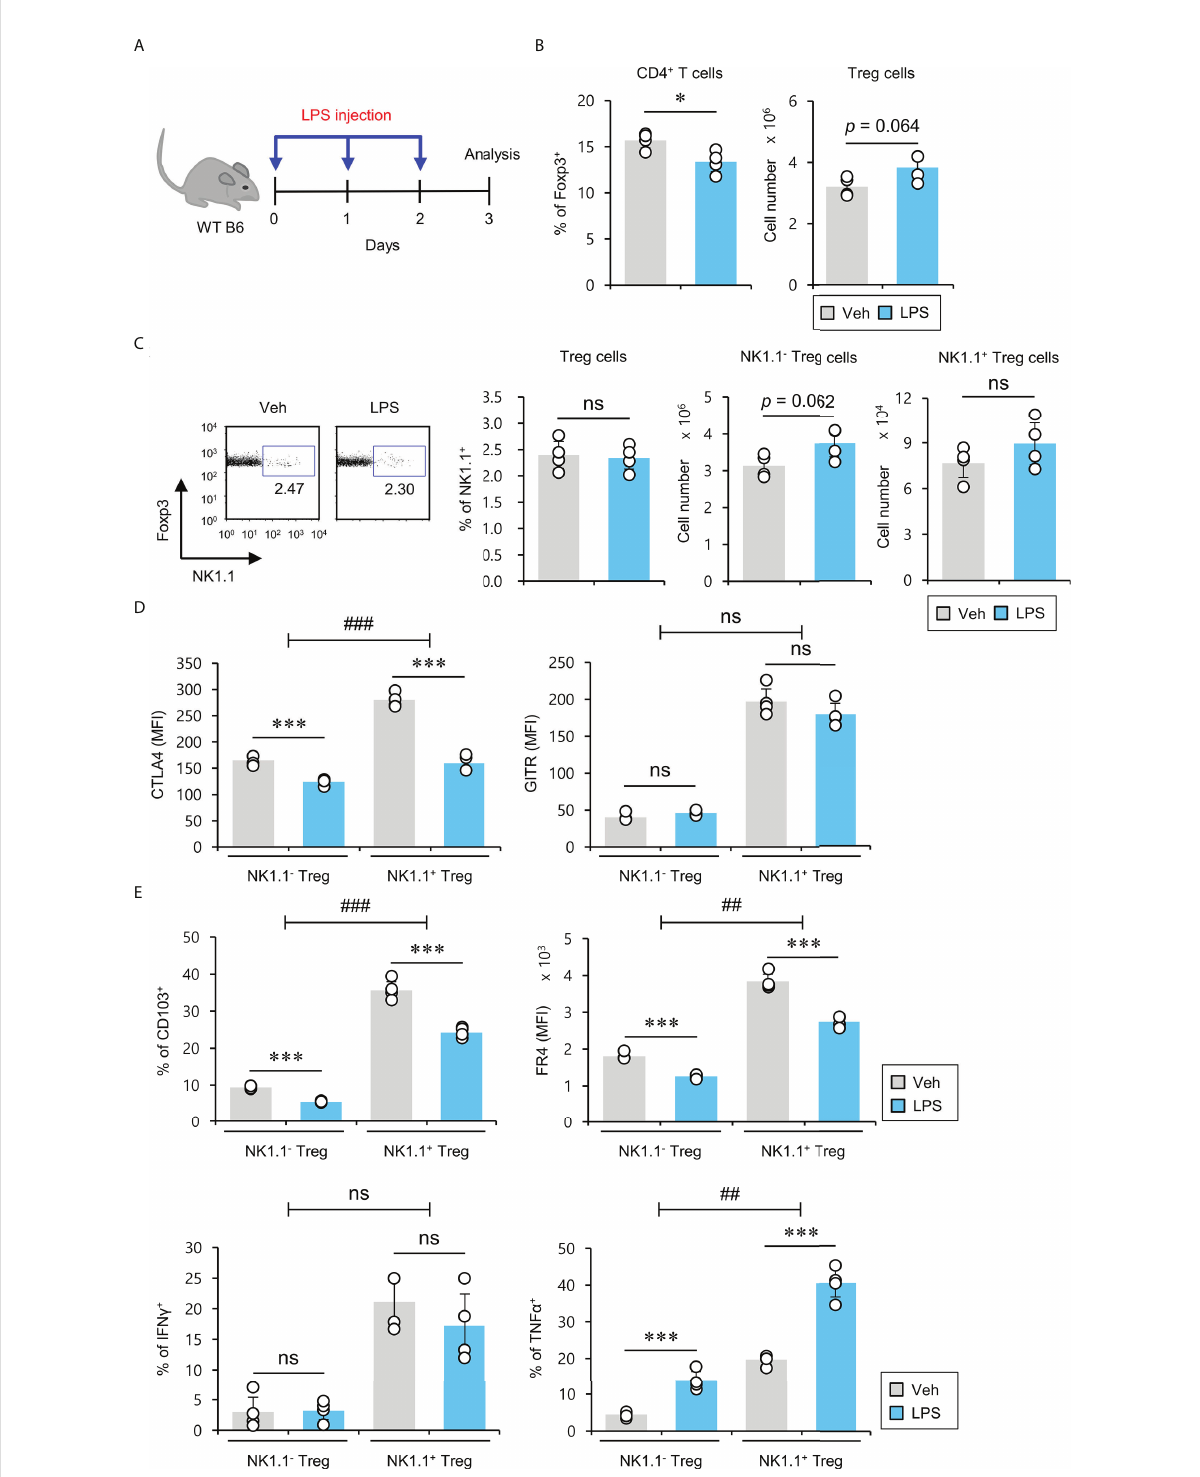
FIGURE 6 LPS-induced systemic in fl ammation downregulates immunosuppressive marker expression but upregulates TNF a production in NK1.1 + Treg cells. (A) WT B6 mice were i.p. injected either LPS (2 mg/kg) or vehicle (Veh) once per day for a total of 3 days, and total splenocytes from these mice were prepared one day after the last injection. (B) The percentage and absolute cell number of Treg cells were assessed by fl ow cytometry. (C) The percentage of NK1.1 + cells among splenic Treg cells and the absolute cell number of both NK1.1 - Treg cells and NK1.1 + Treg cells were assessed by fl ow cytometry. (D, E) The expression of Treg cell-associated molecules (i.e., CTLA4, GITR, CD103, and FR4) and cytokines (i.e., IFN g and TNF a ) on NK1.1 - Treg (NK1.1 - CD4 + Foxp3 + ) and NK1.1 + Treg (NK1.1 + CD4 + Foxp3 + ) cells were evaluated by fl ow cytometry. The mean values ± SD ( n = 4 per group in the experiment; Student ’ s t-test; * p < 0.05, *** p < 0.001). One representative experiment of two experiments is shown. Two-way ANOVA (cell type × treatment) showed an interaction between these two factors ( ## p < 0.01, ### p < 0.001). ns, not signi fi